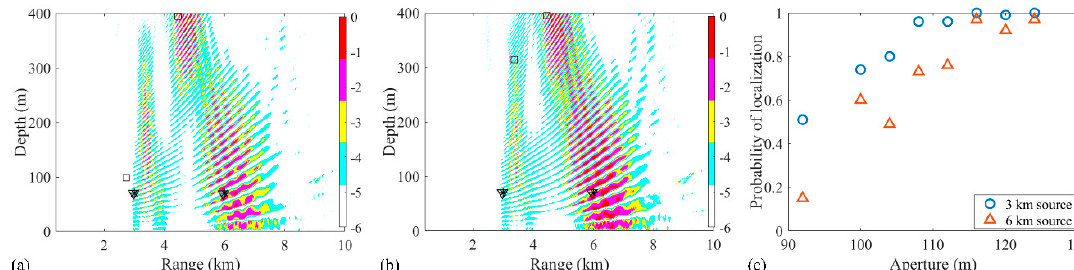
Figure 4. ( a , b ) Ambiguity surfaces generated by different realizations for a VLA from 1735 to 1835 m with fixed spacing using the RAMPMF method, compared to the results shown in Figure 3. The true source positions and the positions estimated by the RAMP and RAMPMF methods are represented by black asterisks, squares, and inverted triangles, respectively; ( c ) The probability of obtaining an accurate estimation of the source depth with different apertures for 3 and 6 km sources.